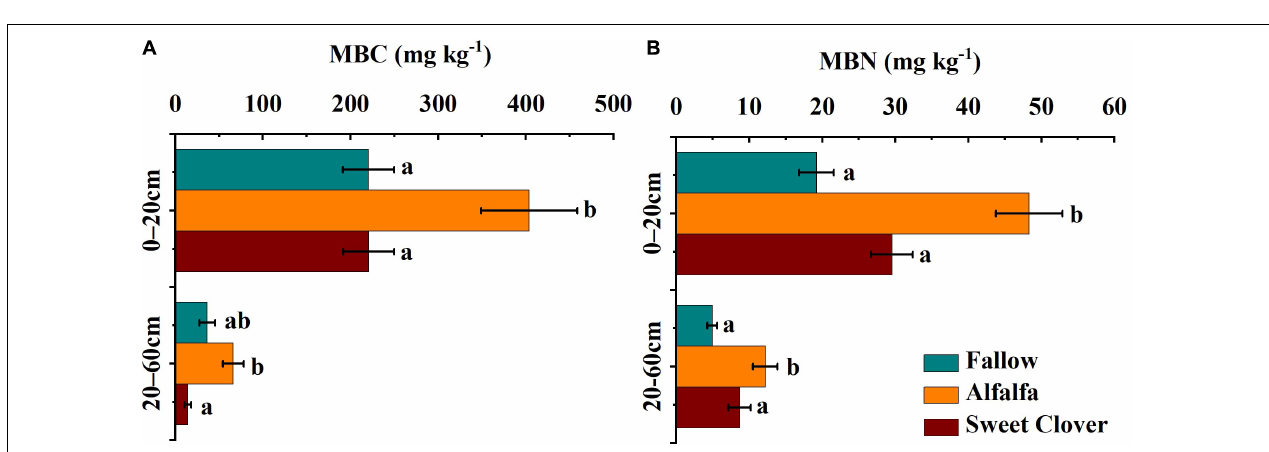
FIGURE 2 | Soil organic carbon (SOC) (A) , TN (B) , TP (C) , AP (D) , NO3 - -N (E) , and NH4 + -N (F) distributions at different soil depths under different revegetation treatments in 2019 (17 years after revegetation). Data represents the mean value ± standard error ( n = 9), and the different letters indicate significant differences at the p < 0.05 level. (SOC, soil organic carbon; TN, total nitrogen; TP, total phosphorus; AP, available phosphorus; NO 3 - -N, nitrate nitrogen; NH 4 + -N, ammonium nitrogen).